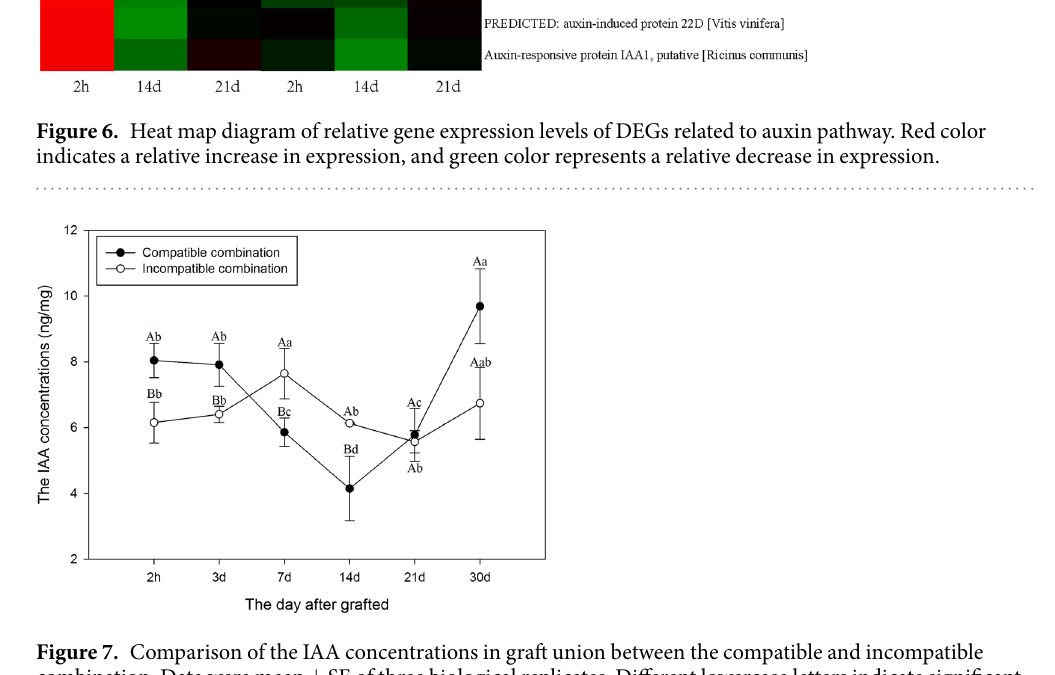
Figure 7. Comparison of the IAA concentrations in graft union between the compatible and incompatible combination. Data were mean ± SE of three biological replicates. Different lowercase letters indicate significant difference at the 0.05 level among 6 sampling sites, different capital letters indicate significant difference at the 0.05 level between compatible combination and incompatible combination at the same sampling site,